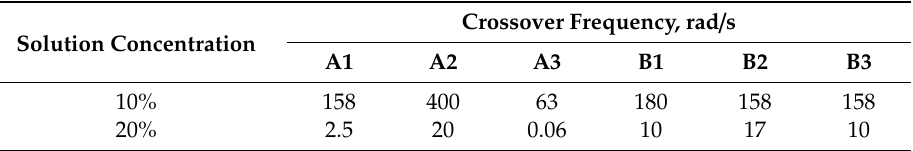
Figure 8. Frequency dependences of the moduli of 10 ( a ) and 20% ( b ) copolymer solutions (series A).